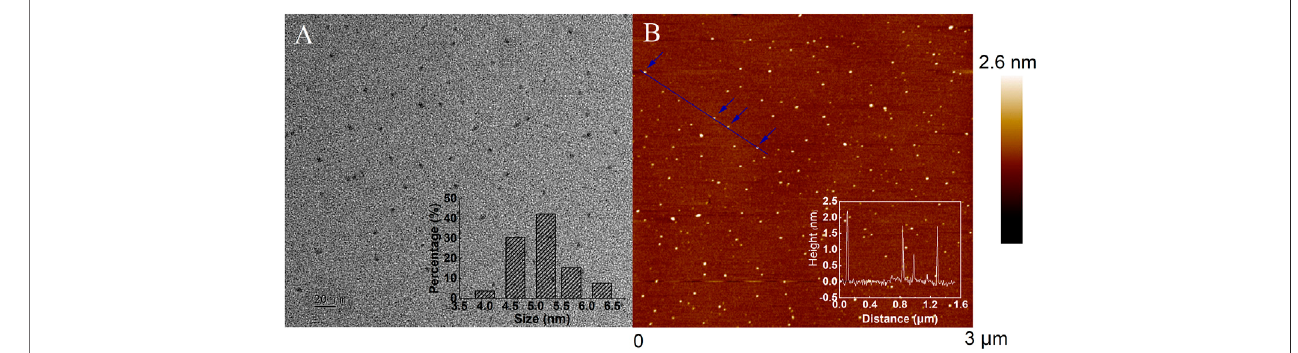
FIGURE 2 | (A) TEM and (B) AFM images of the CQDs.